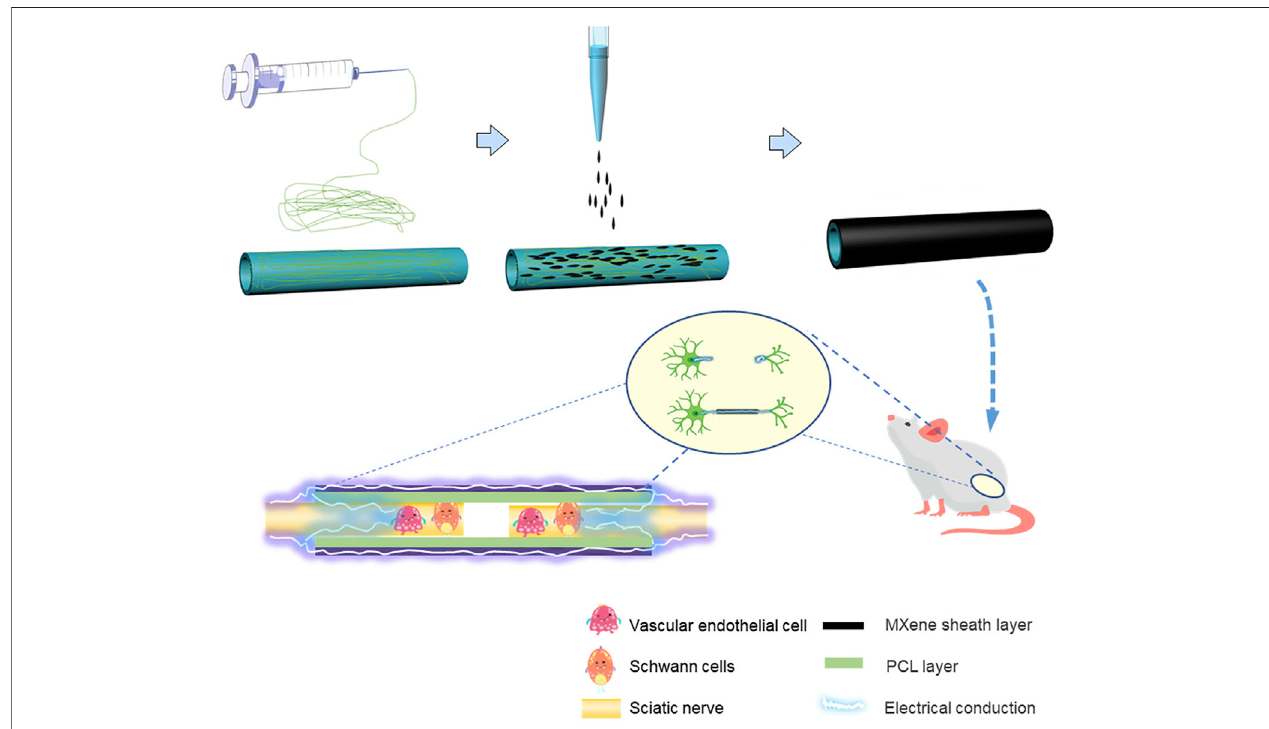
FIGURE1| Schematicsummaryillustrationoftheworkconductedinthisarticle.ThePCLNGCswerepreparedbyelectrospinning,toprepareMXene-PCLNGCs, MXene solution was uniformly coated on the outer surface of PCL NGC by spraying technology. The obtained MXene-PCL NGCs that could transmit self-originated electrical stimulation were implanted in the rat model and fi nally repaired the peripheral nerve